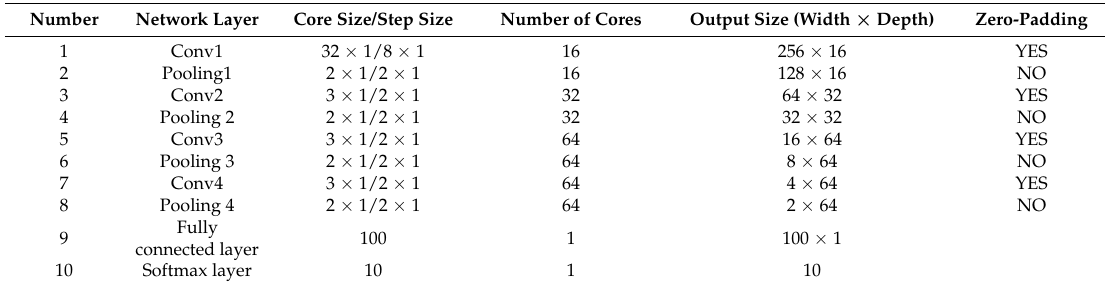
Table 1. Structures and parameters of